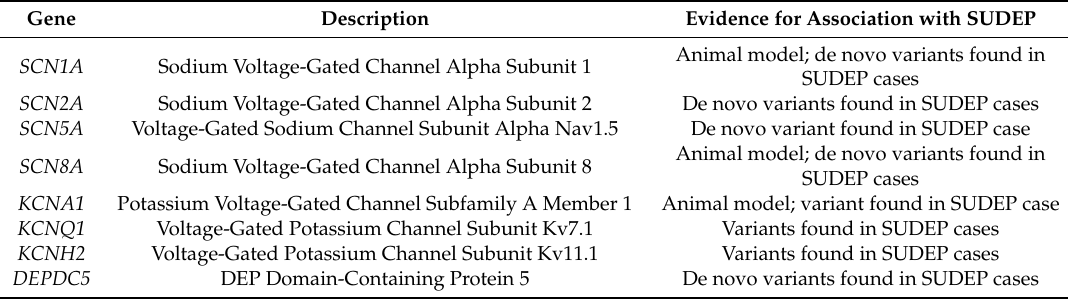
Table 4. Genes associated with SUDEP (adapted from Reference